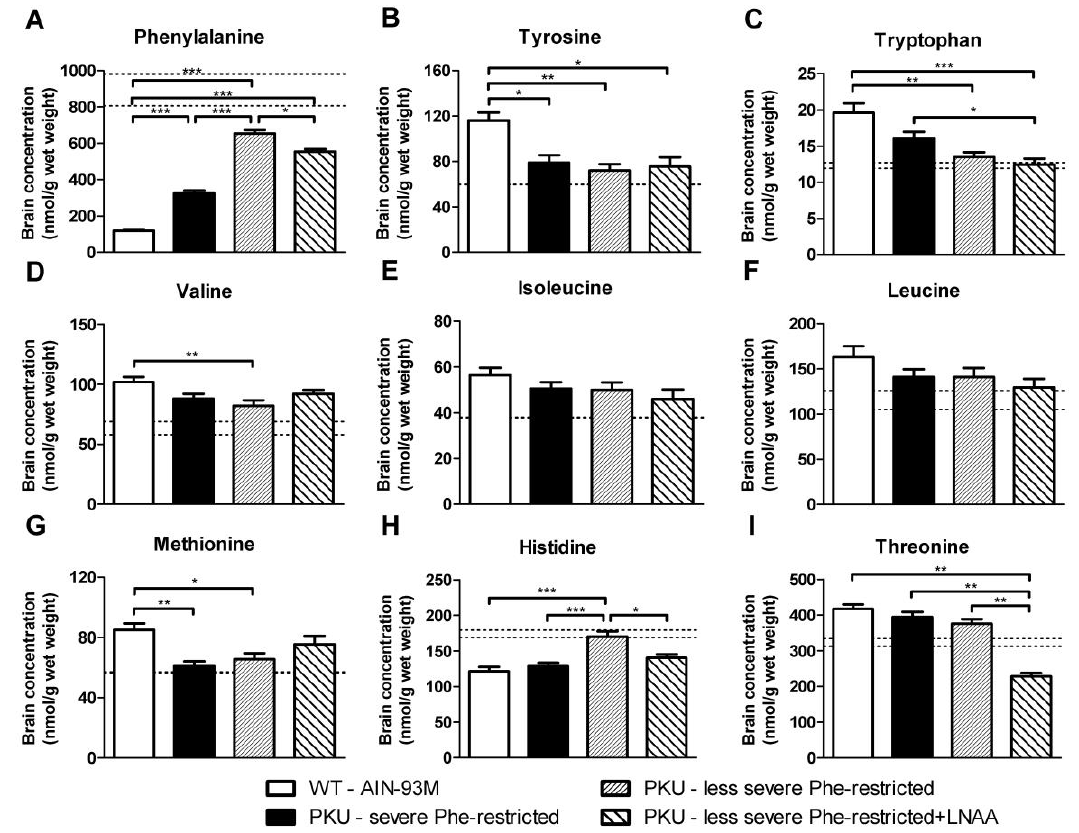
Figure 4. Brain concentrations of ( A ) phenylalanine, ( B ) tyrosine, ( C ) tryptophan, ( D ) valine, ( E ) isoleucine, ( F ) leucine, ( G ) methionine, ( H ) histidine, and ( I ) threonine in WT and PKU mice after six weeks of receiving various diets. Numbers of mice are n = 10 for all experimental groups. Untransformed data are expressed as mean ± SEM. * p < 0.05; ** p < 0.01; *** p < 0.001 (two-sided). For comparison, dashed lines represent mean brain amino acid concentrations obtained in C57Bl / 6 PKU mice on AIN-93M diet in previous experiments [21,23]. Previously obtained mean brain amino acid concentrations in PKU mice on AIN-93M diet were expressed as proportion of data in respective WT mice and then multiplied by mean brain amino acid concentrations of WT mice in the present study.